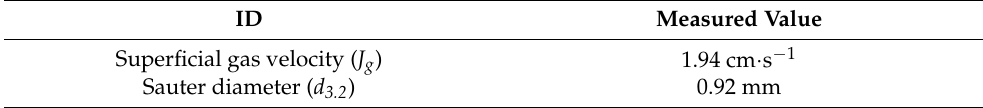
Table 4. Values obtained by the measurements carried out in the pilot column during the